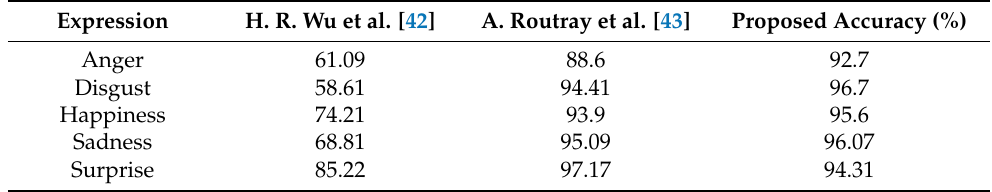
Table 8. Accuracy Comparison for Facial Expression CK+.